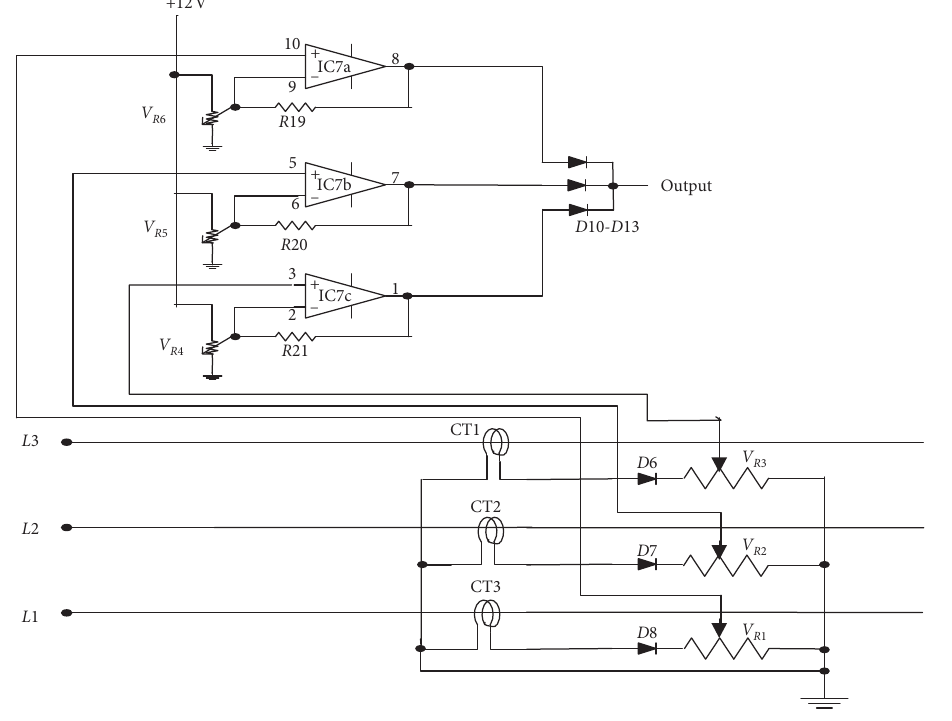
Figure 5: The circuit diagram of the overcurrent sensing and conditioning